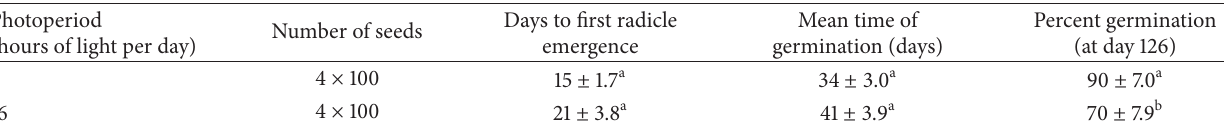
Table 1: The effect of light regime on the germination characteristics of Calluna vulgaris seeds at 15 ∘ C. Storage period at room temperature before trial: 6 days. Mean values ± standard deviations. In each column, groups that showed significant differences ( 𝑃 < 0.05 ) are indicated with different letters.